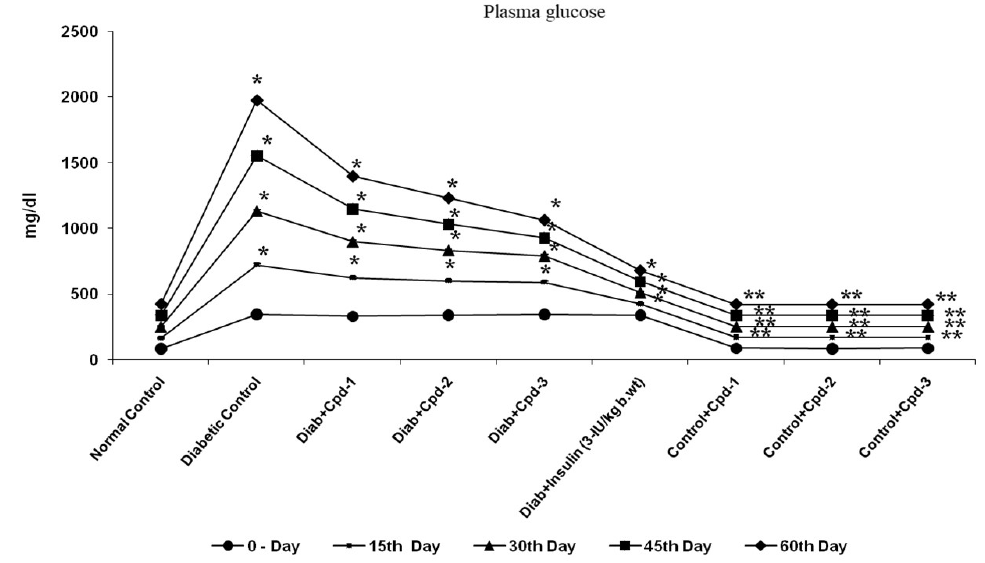
Figure 2. Effect of novel triterpenoids on plasma glucose in STZ-induced diabetic rats compared with the effect of insulin. Each bar represents Mean ± SEM of 6 animals. Significance at p < 0.05; *, compared with control; **, compared with diabetic control.